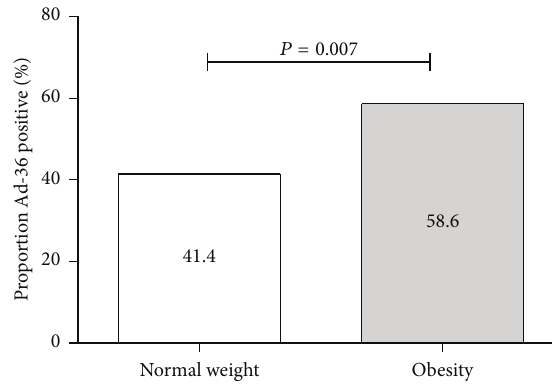
Figure 1: Ad-36 seropositivity in normal weight and obese